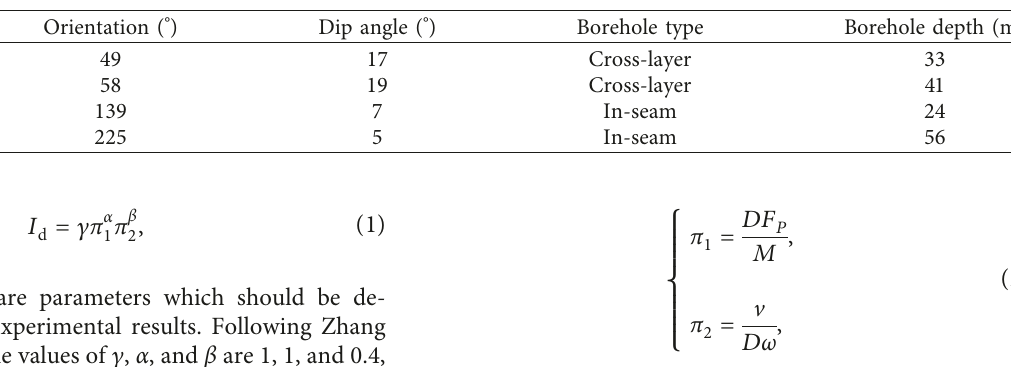
Figure 6: PDC bit. Table 3: Borehole